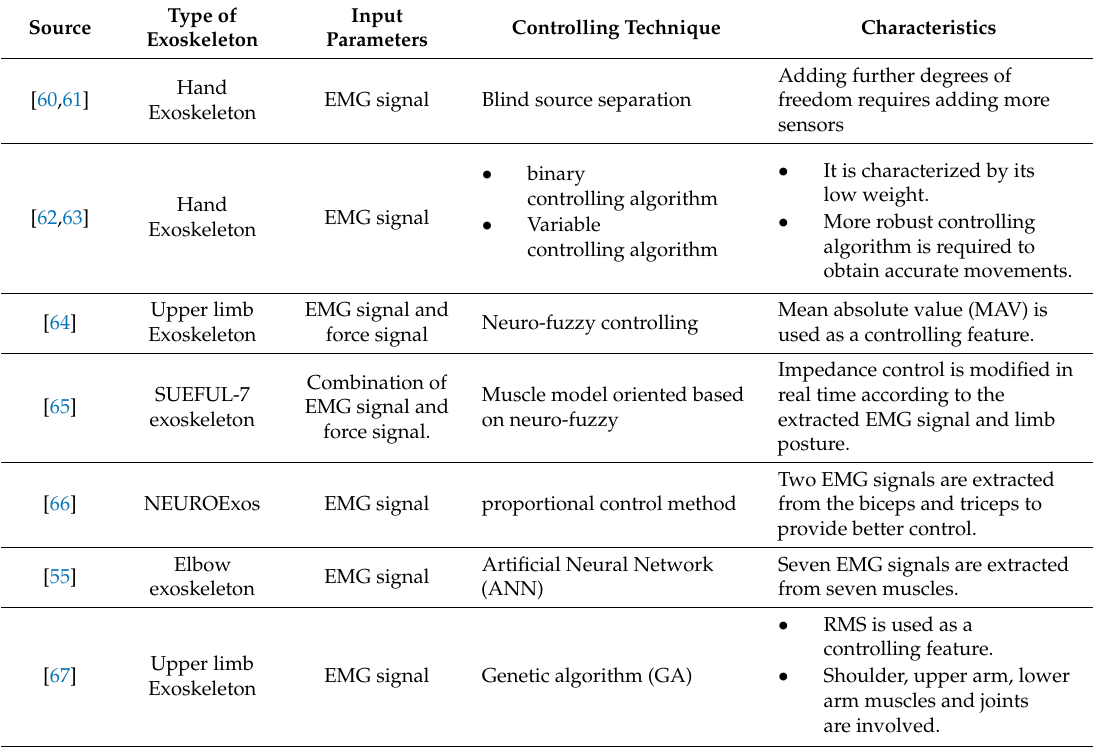
Table 4. Summary of electromyogram (EMG)-driven robots and their control